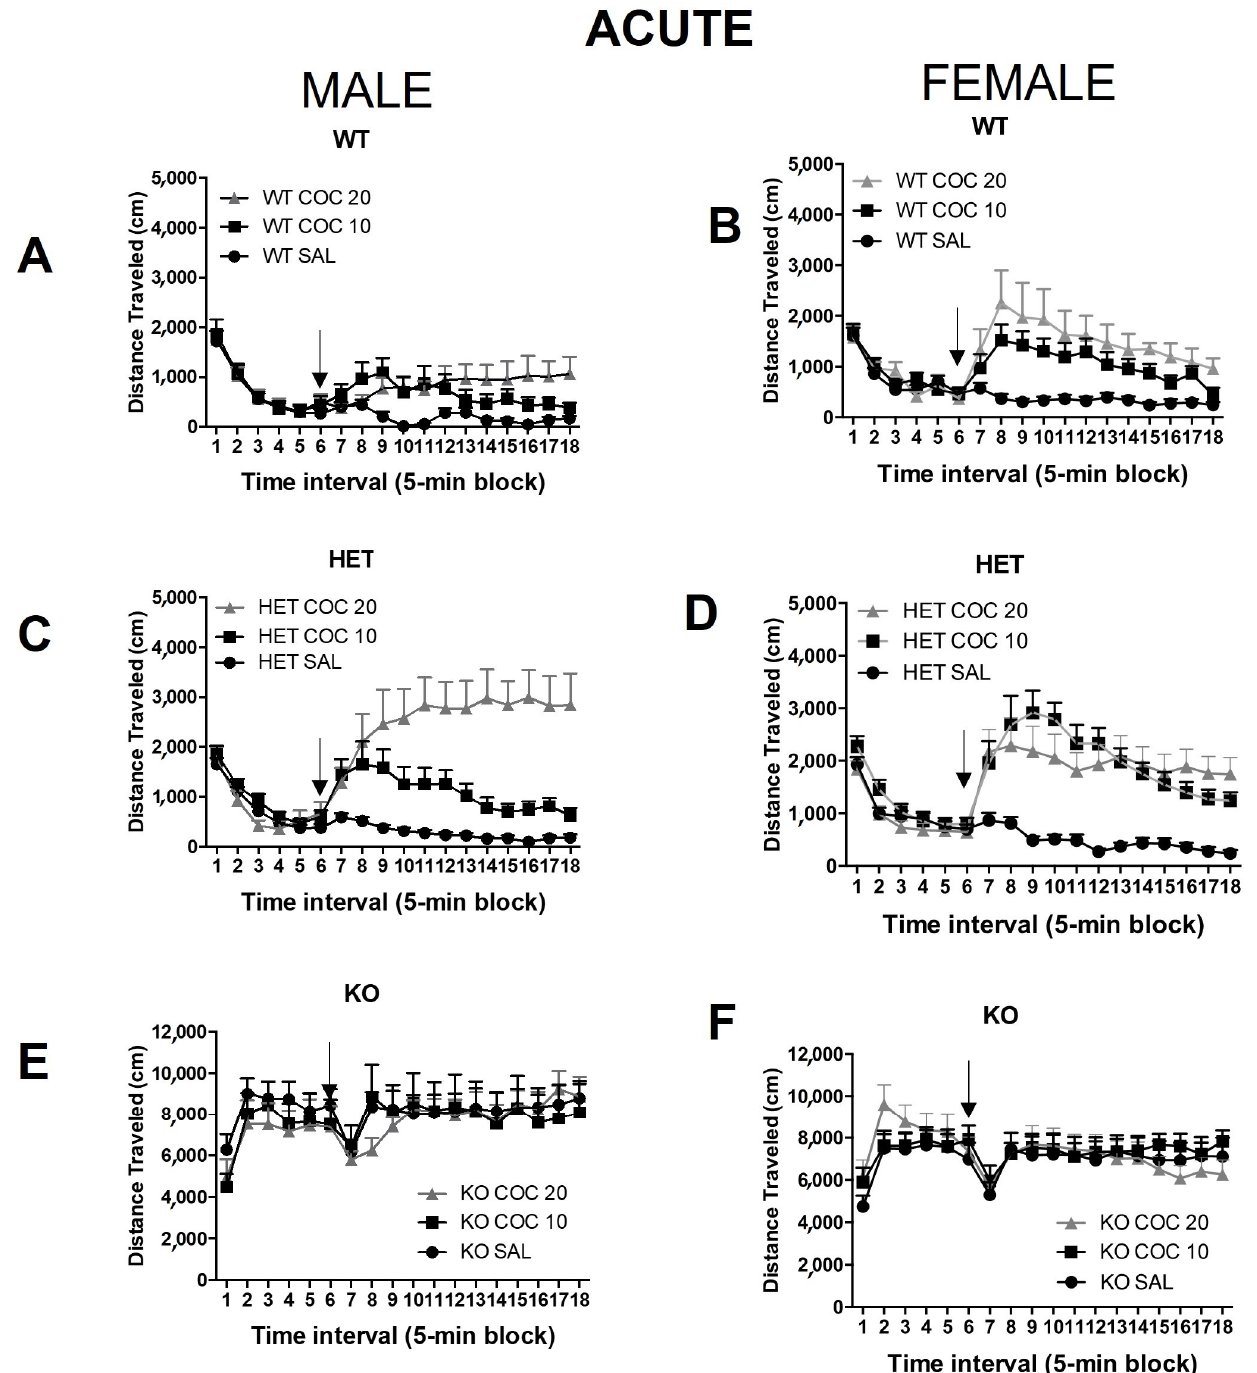
Figure 1. Acute effects of cocaine on locomotor activity in DAT mutant rats. At PND35, rats were habituated to the locomotor test chamber for 30 min. Cocaine (0, 10 or 20 mg/kg) was injected (ip) and rats were returned to the chamber and monitored for 60 more min. Time course of locomotor activity of male ( A ) Wild-type (WT), ( C ) Heterozygous (HET) DAT rat and ( E ) Homozygous (KO) DAT Knockout rats, and female ( B ) Wild-type (WT), ( D ) Heterozygous (HET) DAT rat and ( F ) Homozygous (KO) DAT Knockout rats. Arrow indicates the time of treatment. Mean ± SEM. (males: WT N = 15, HET N = 36, KO N = 17; females: WT N = 24, HET N = 24, KO N = 23).